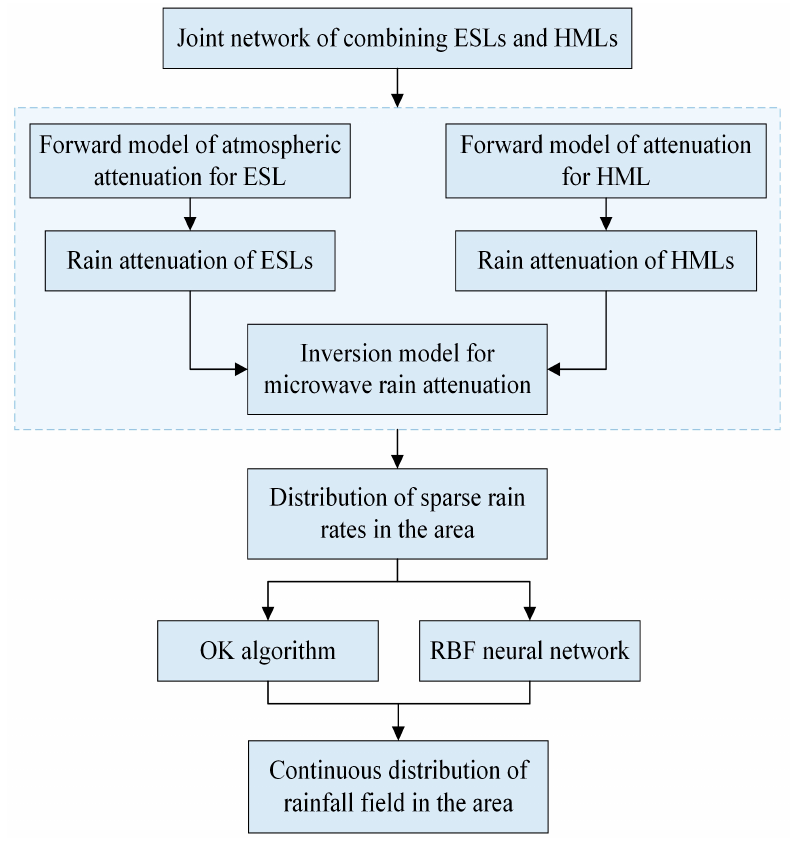
Figure 1. The process for retrieving rainfall fields in the area by combining ESLs and HMLs.